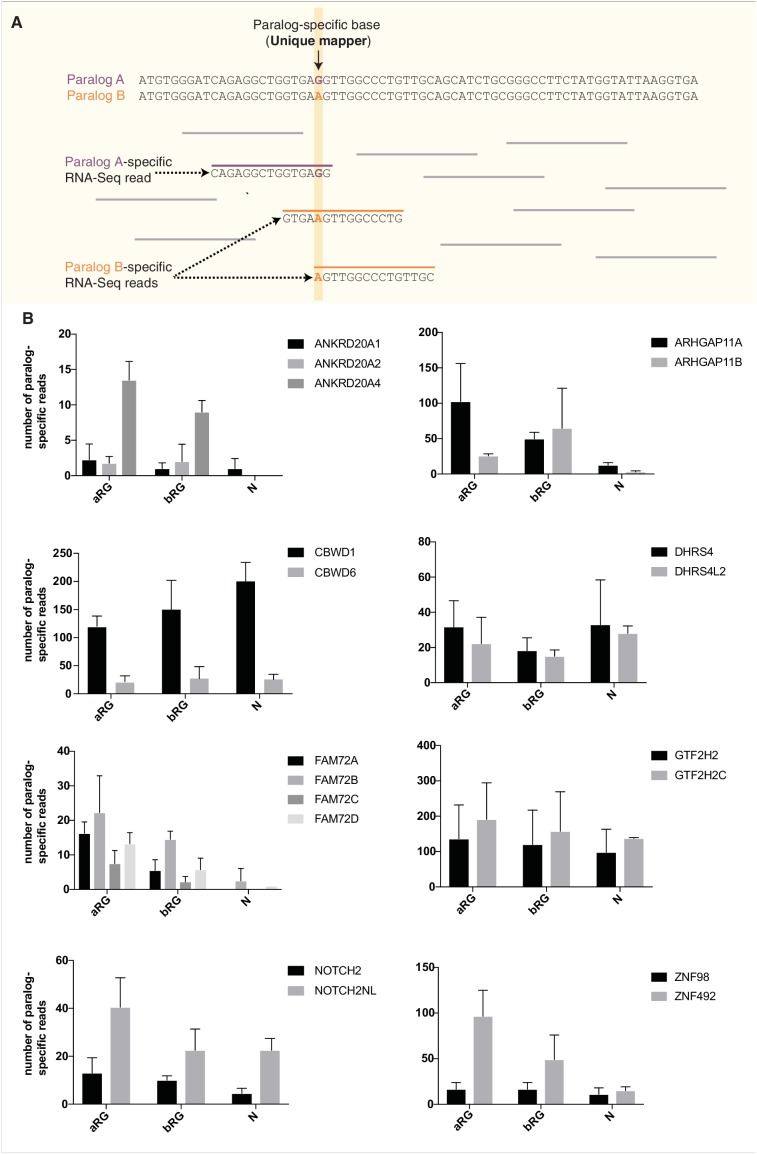
Comparison of the paralog-specific mRNA expression between 11 human-specific cNPC-enriched genes and their respective ancestral paralog in aRG, bRG and neuron-enriched cell populations from fetal human neocortex.(A) Diagram outlining the strategy used to ascertain paralog-specific mRNA expression in a given cell type of interest. mRNA sequences of an ancestral vs. a human-specific paralog (paralog A vs. B in the example shown) were aligned, and the homologous, yet distinct, core sequences of each alignment were extracted. The corresponding sequences of each paralog were used as a mapping reference for RNA-Seq reads from aRG, bRG and neuron-enriched cell populations from fetal human neocortex (Florio et al., 2015). Only reads aligning to ‘unique mappers’, i.e. paralog-specific sites (SNPs or indels), were used for the analysis shown in (B). In the example shown, paralog-specific reads specific for paralog A or paralog B, as defined by the paralog-specific base (vertical yellow line) are colored in purple and orange, respectively. (B) Bar plots showing the total numbers of paralog-specific RNA-Seq reads (identified as described in (A)) found in aRG vs. bRG vs. neuron-enriched (N) cell populations from fetal human neocortex (Florio et al., 2015). Grey bars indicate human-specific genes; black bars indicate their respective ancestral paralog. Data are the mean of four individual samples isolated from two human specimens; errors bars, SD.